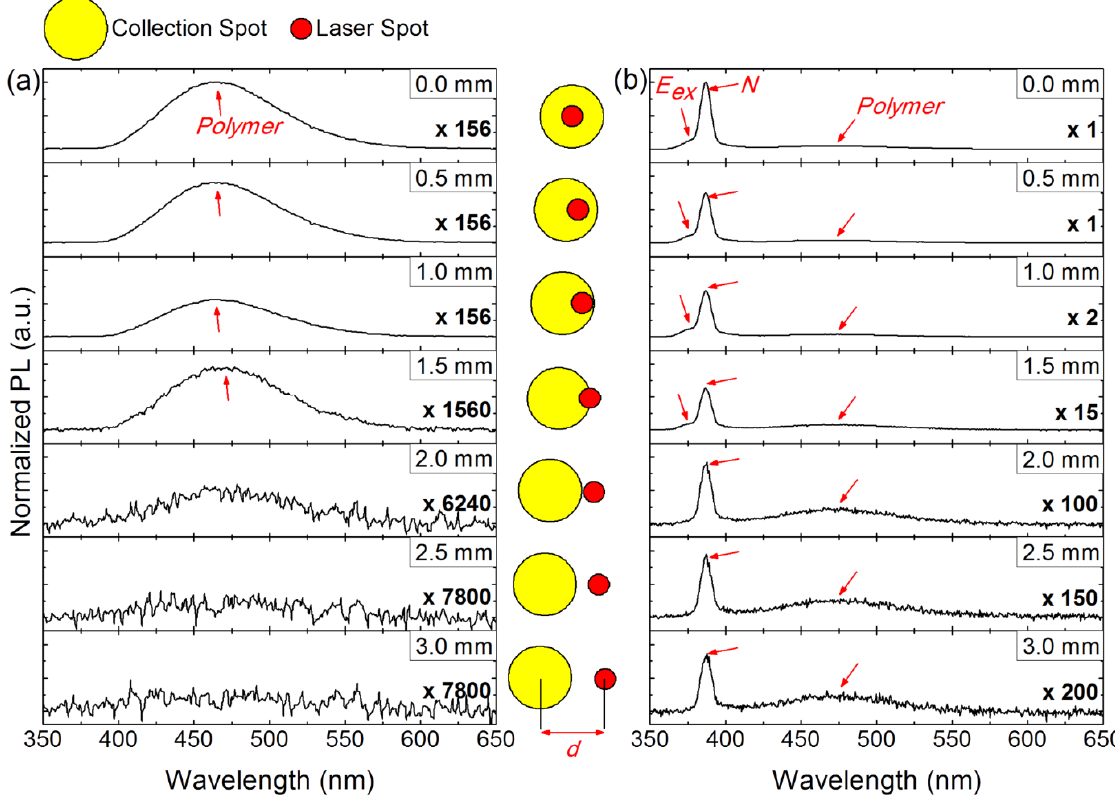
Figure 5. Evolution of the photoluminescence (PL) spectra for the polymer fluorescent film coated on quartz, S0 sample ( a ) and on the ZnO layer, S1 sample ( b ) as a function of the distance ( d ) separating the center laser spot and the axis of the collection objective. The PL spectra are all plotted on the same y -axis scale and normalized by the PL intensity recorded at the maximum emission wavelength of the N -line for d = 0 mm. The inset between the two figures presents a sketch of the evolution of d. Reprinted with permission from